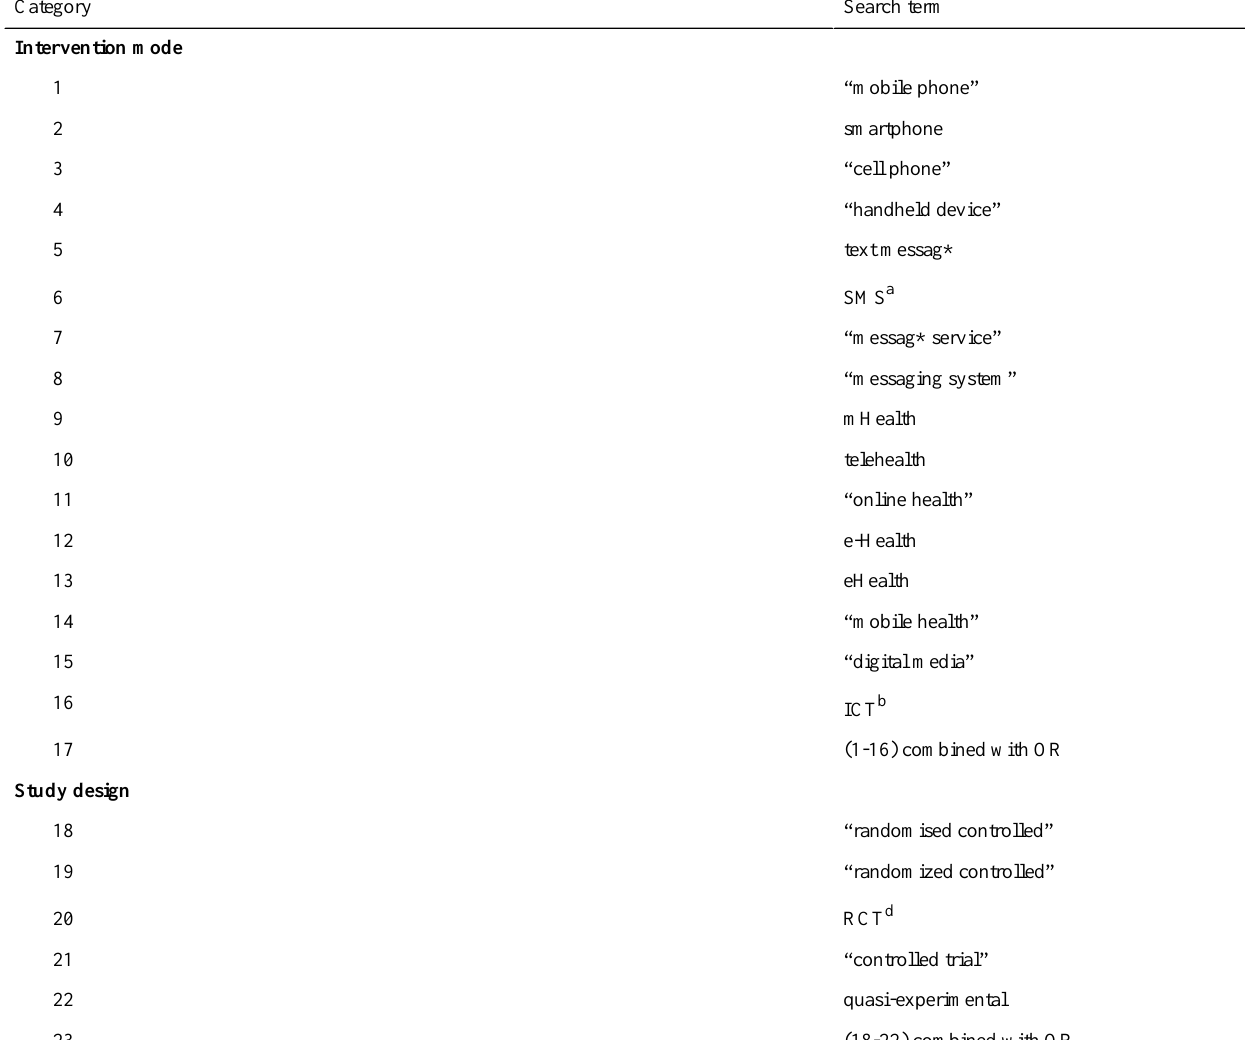
Table 1. Electronic database search terms and combinations. Asterisks were used to search for words beginning with these